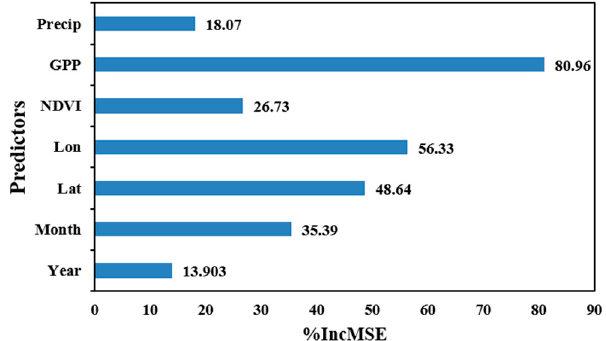
Figure 10. The importance of the predictors in the random forest (RF) model.